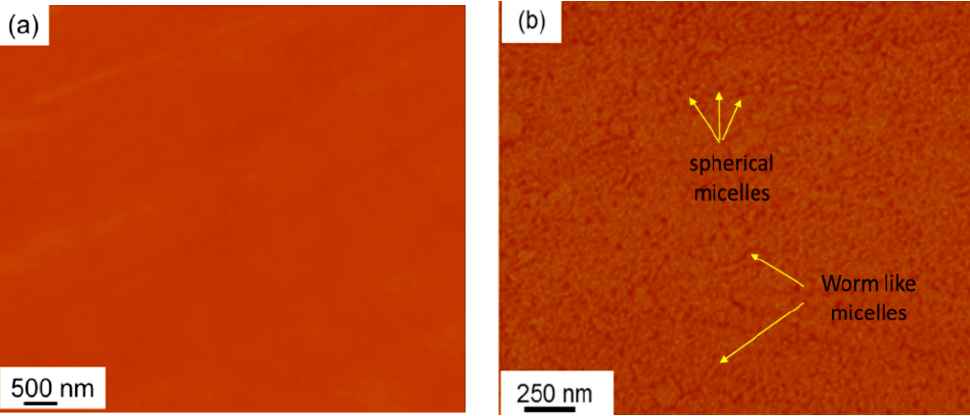
Figure 7. Atomic force microscope (AFM) height images polished surfaces: ( a ) Neat EP_H1, and ( b ) EP_6 BCP modified epoxy system revealing nanostructures such as spherical and wormlike micelles.